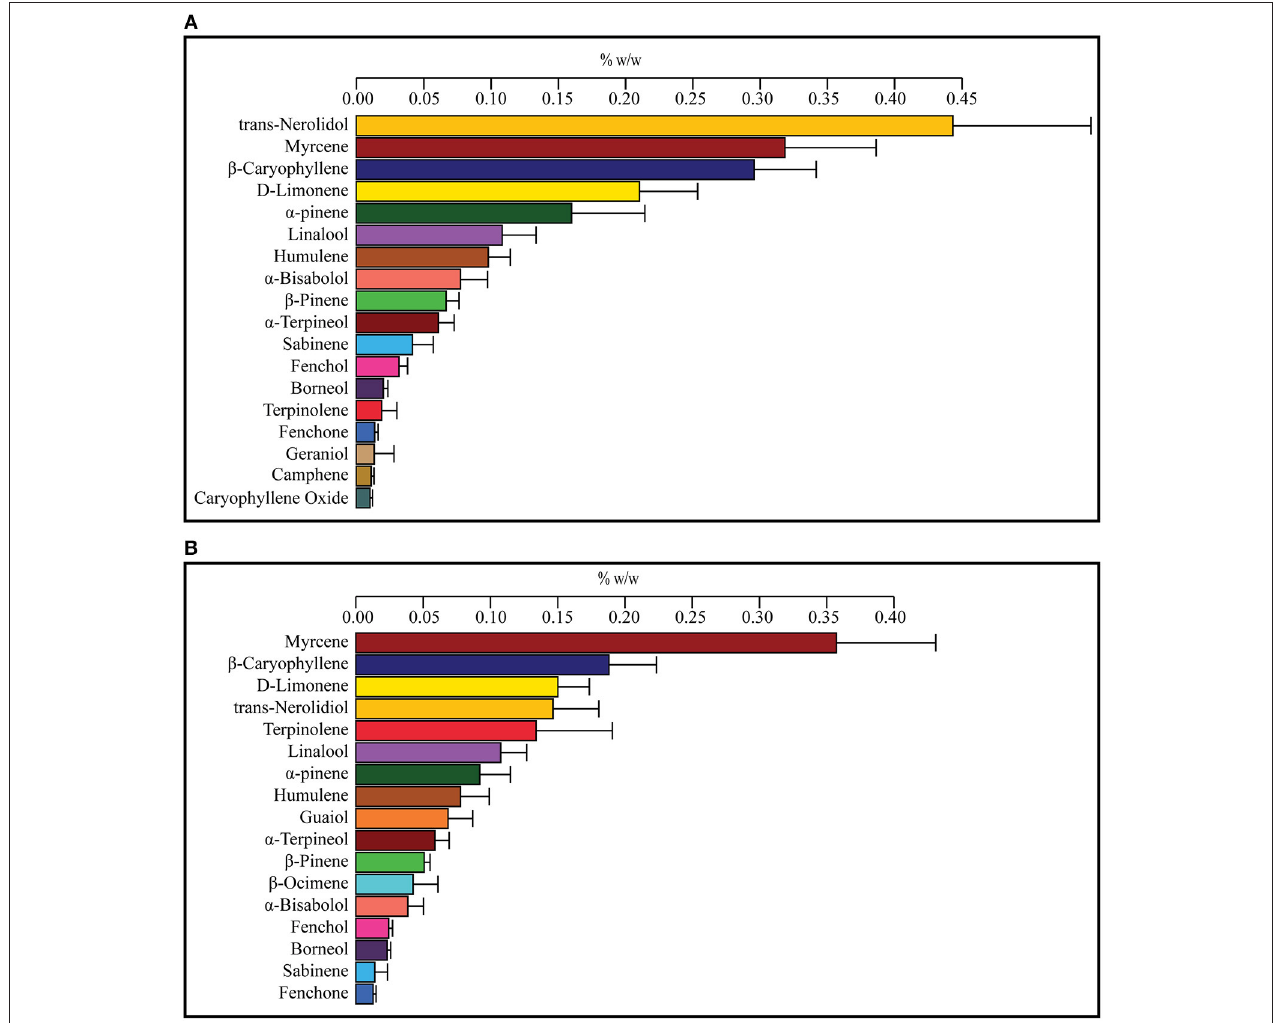
FIGURE 2 | Weighted average terpene concentrations for the top four most effective (A) and top four least effective (B) cannabis strains as rated by medical marijuana patients. Patients were asked to select the cannabis strain(s) that were the most effective or least effective for the treatment of their anxiety. Selected strains were analyzed for the concentration of cannabinoids and terpenes and weighted average values for the most and least effective groups calculated using the number of votes as a weighting factor. Values over 0.01% w/w are